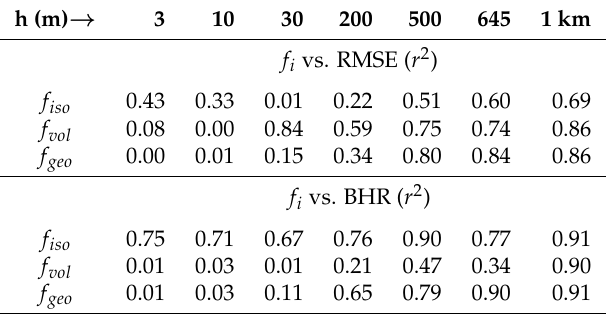
Table 5. Coefficient of determination r 2 of the RTLS parameters with respect to the RMSE (first set) and the BHR (second